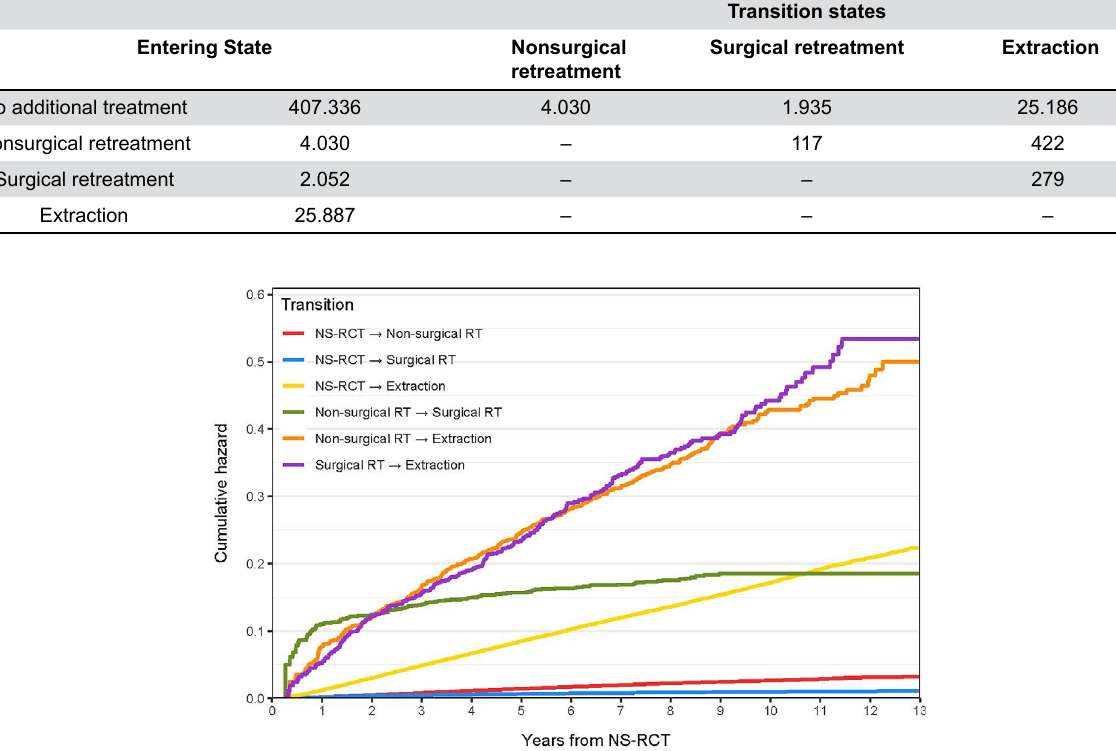
Figure 2- Transitions between failure states based on time from NSRCT